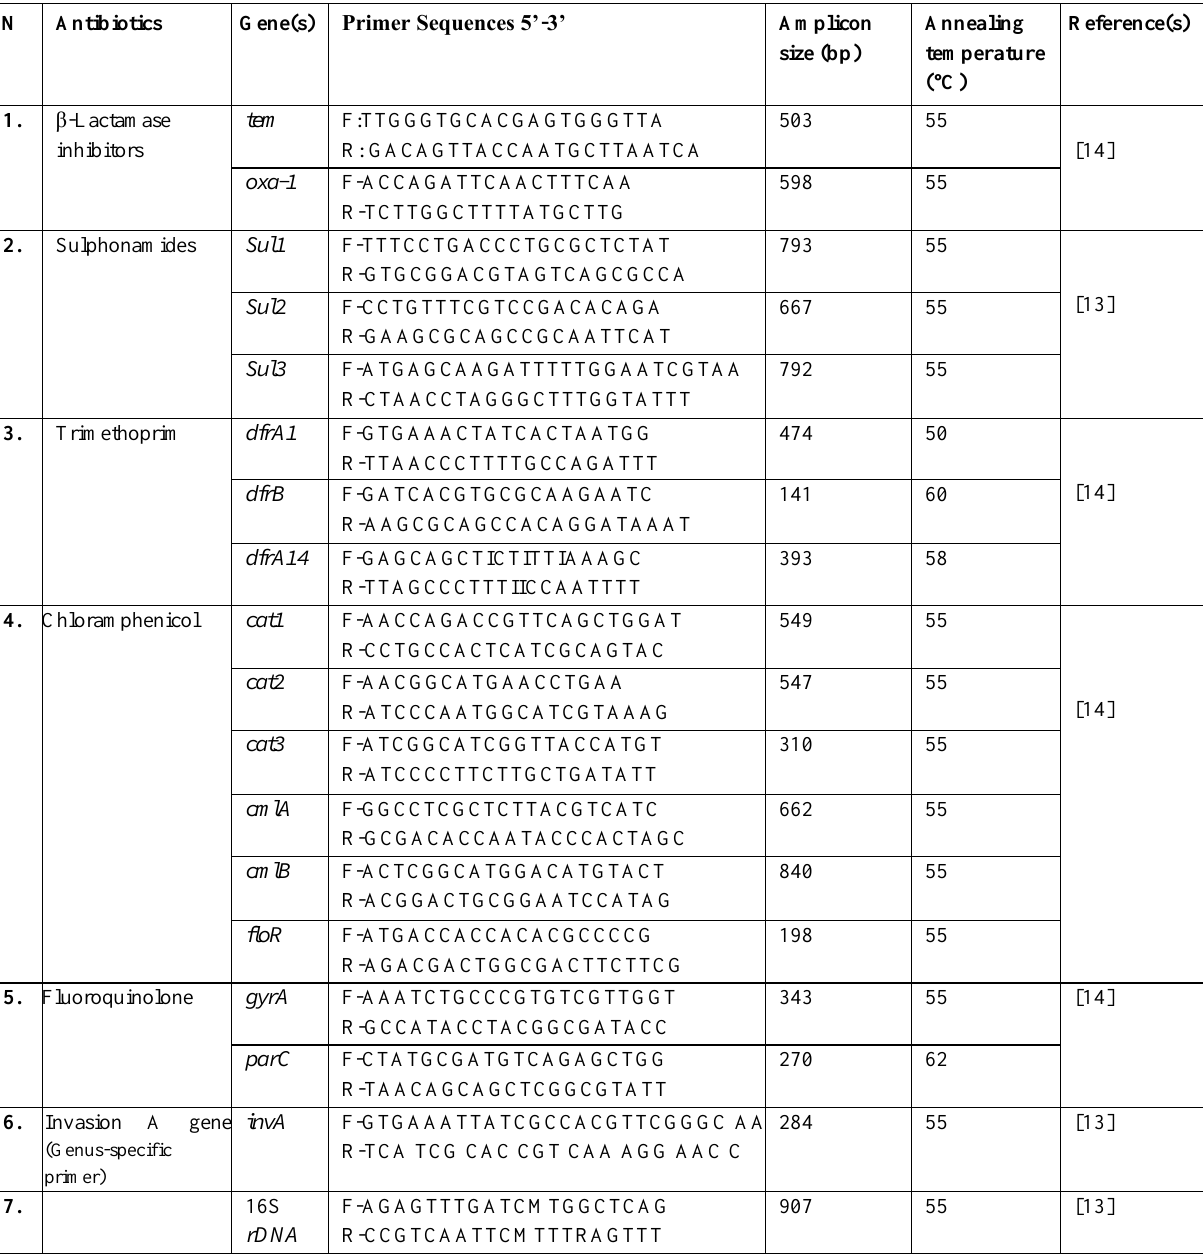
Table 1. Primers sequence specific to different antibiotic resistant